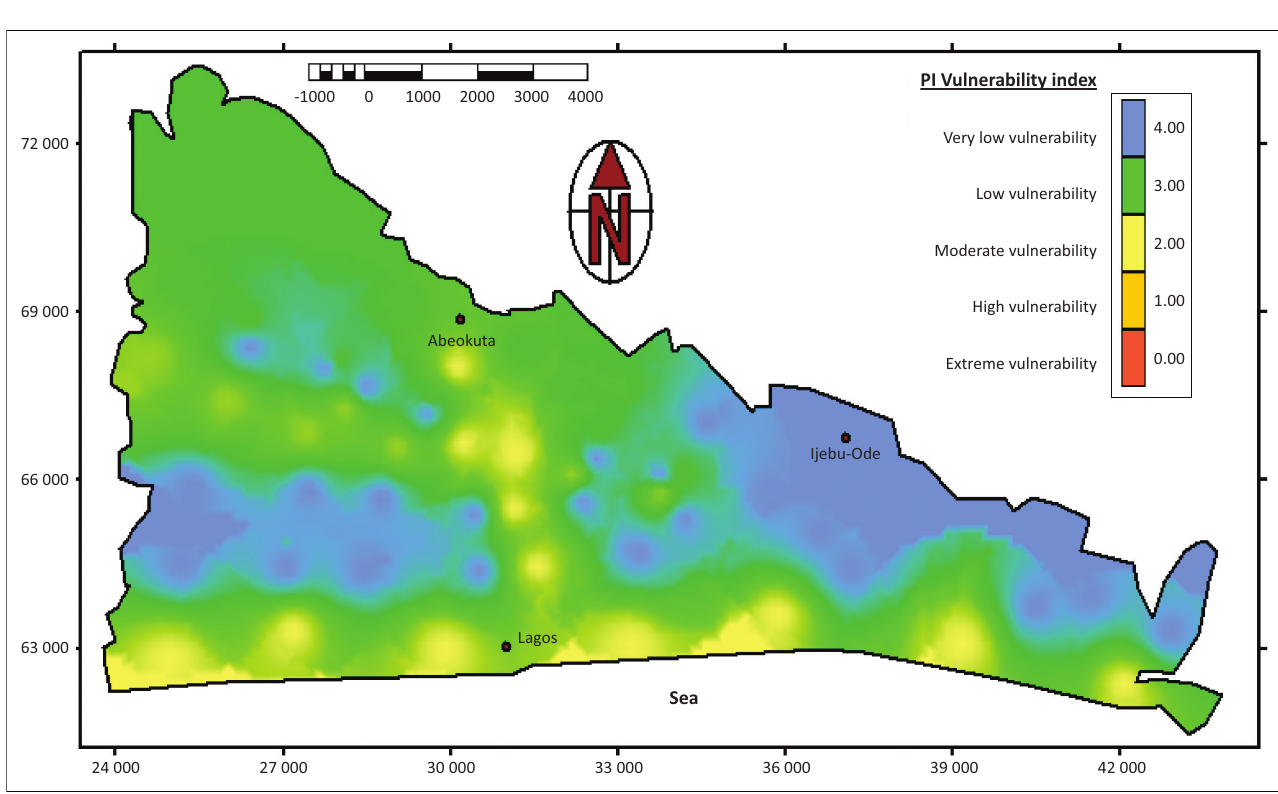
FIGURE 5: PI vulnerability map of the Dahomey